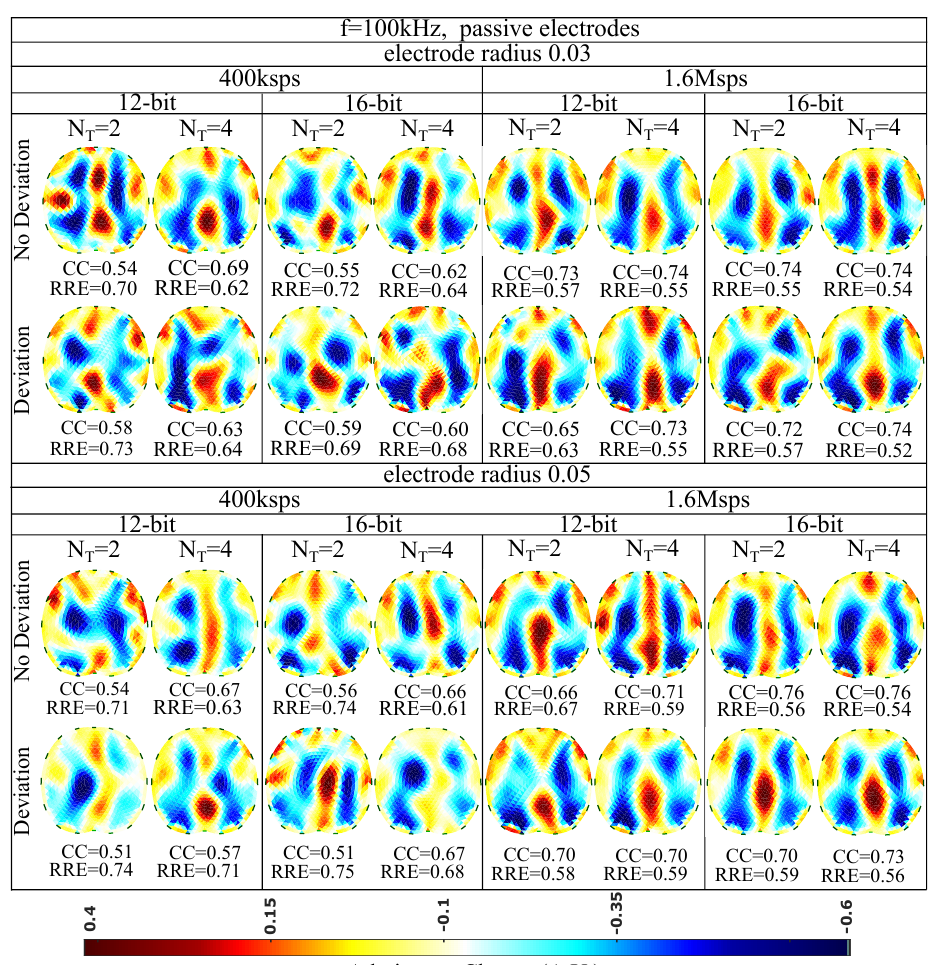
Figure 10. Simulation results for 100 kHz input signal and passive electrode configuration. All further hardware configurations, as well as the corresponding CC s and RRE s, are noted in the